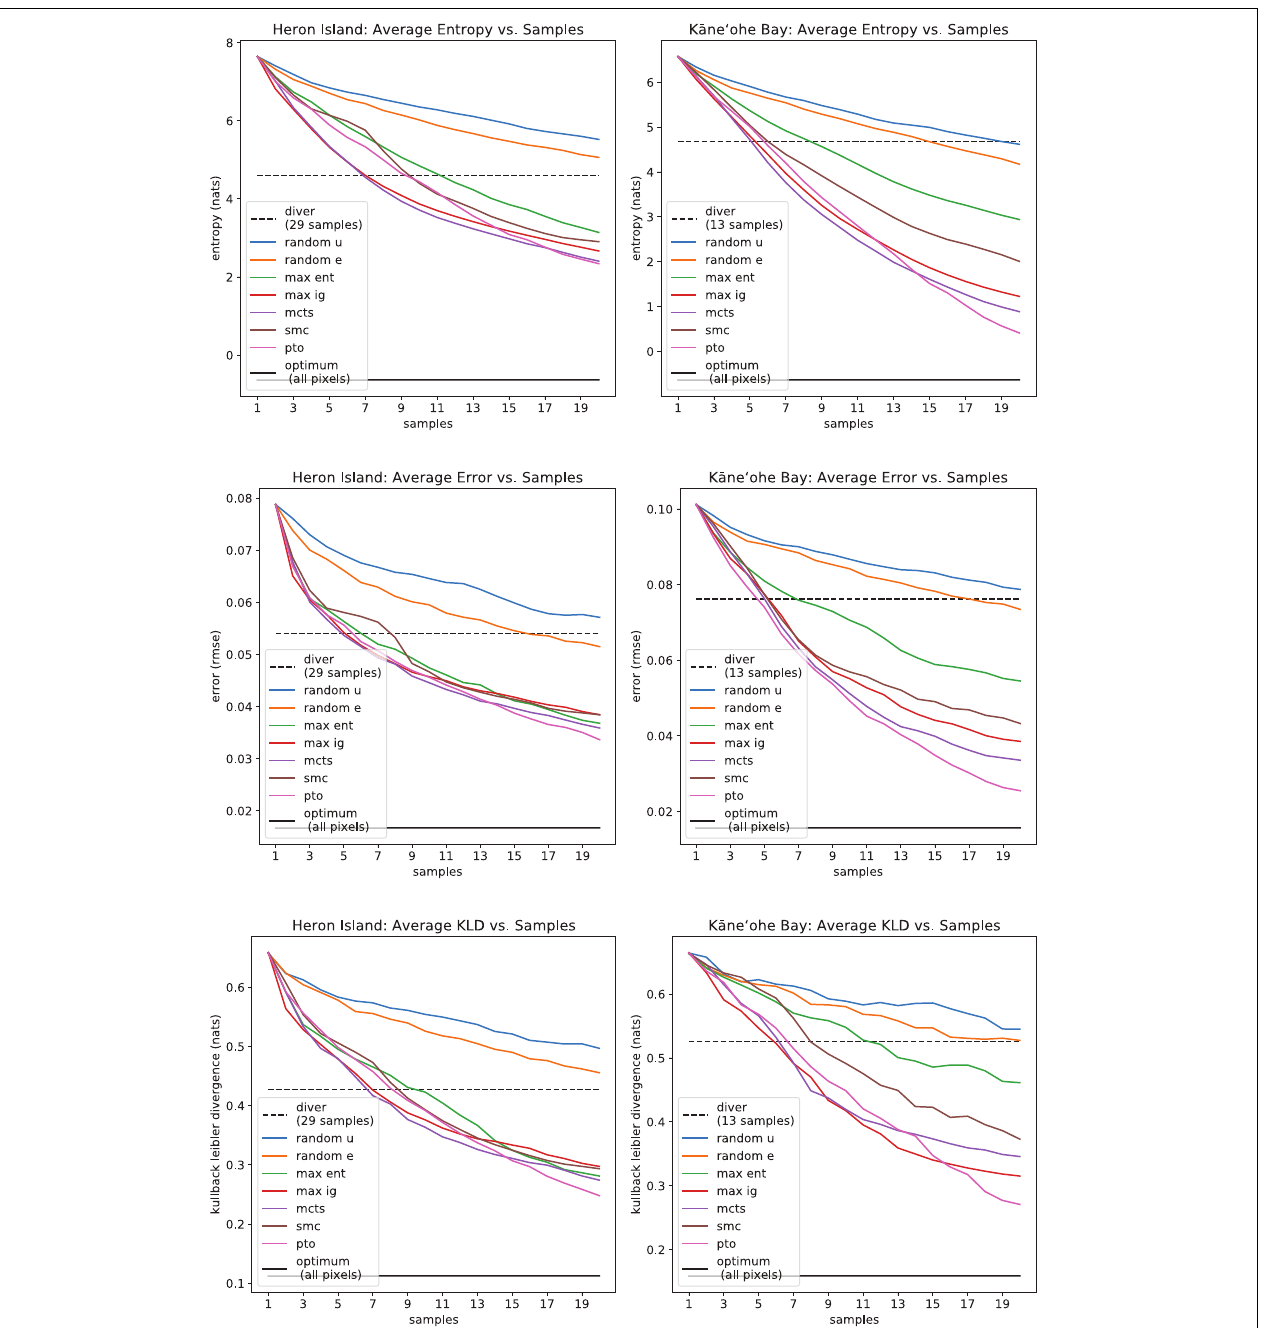
FIGURE 12 | Average model uncertainty (Shannon entropy, top row ), spectral reconstruction error (RMSE, middle row ), and unmixing accuracy (KLD, bottom row ) as a function of